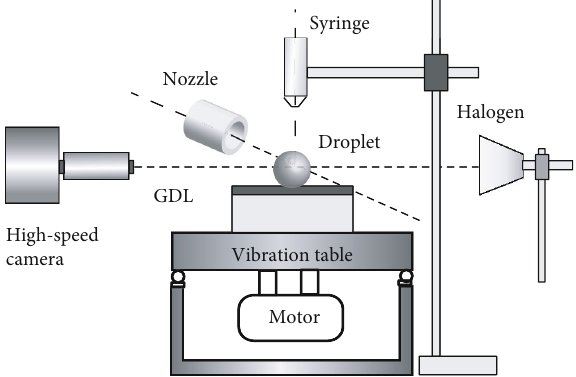
Figure 2: The schematic diagram of droplet vibration